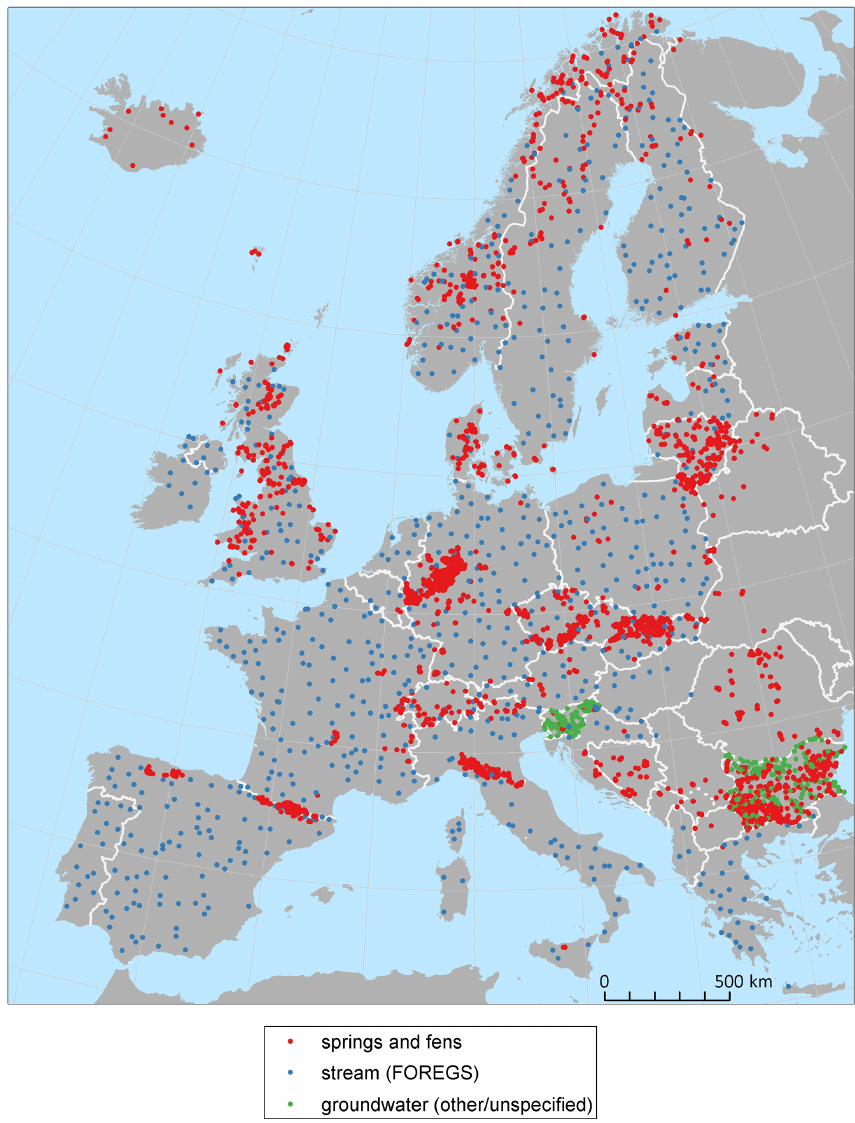
Figure 2. Spatial distribution of the three groups of calibration data collected for modelling groundwater pH and Ca 2 + in European fens (original and literature data from springs and fens; data from streams from the FOREGS Geochemical Atlas of Europe ; other data). Other data include public data from national groundwater monitoring in Bulgaria and Slovenia. For separate maps of pH and Ca 2 + see Fig. S5 in the